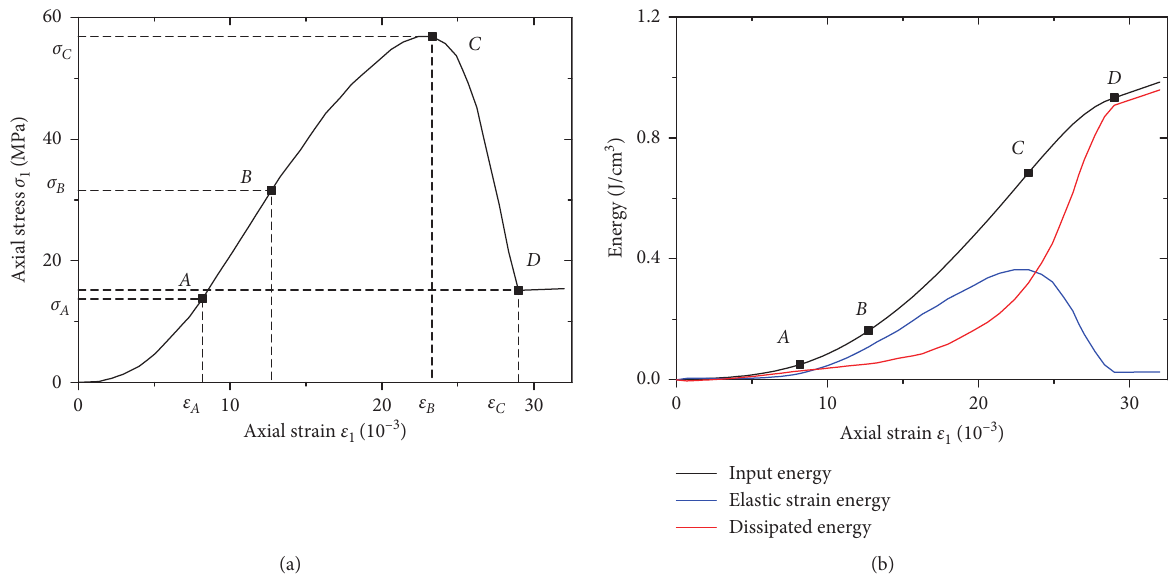
Figure 3: The process of deformation: (a) complete stress-strain curve; (b) energy evolution curve.